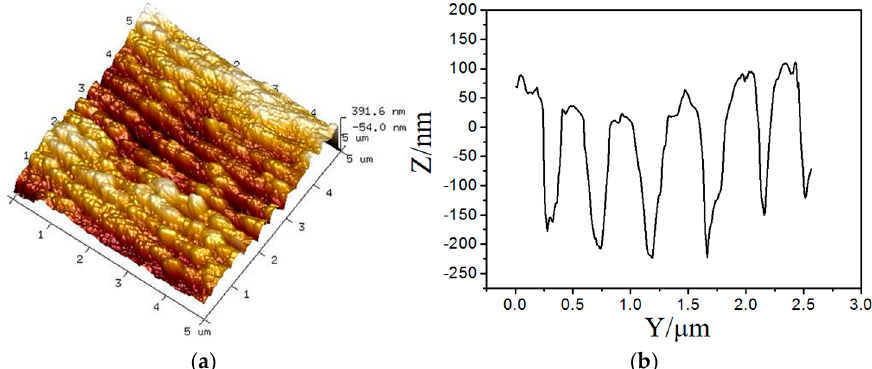
Figure 3. Surface morphology and cross-sectional surface line profile of the LIPSS on the AISI 304L steel surface. ( a ) 3-D surface morphology; ( b ) Cross-sectional surface profile.